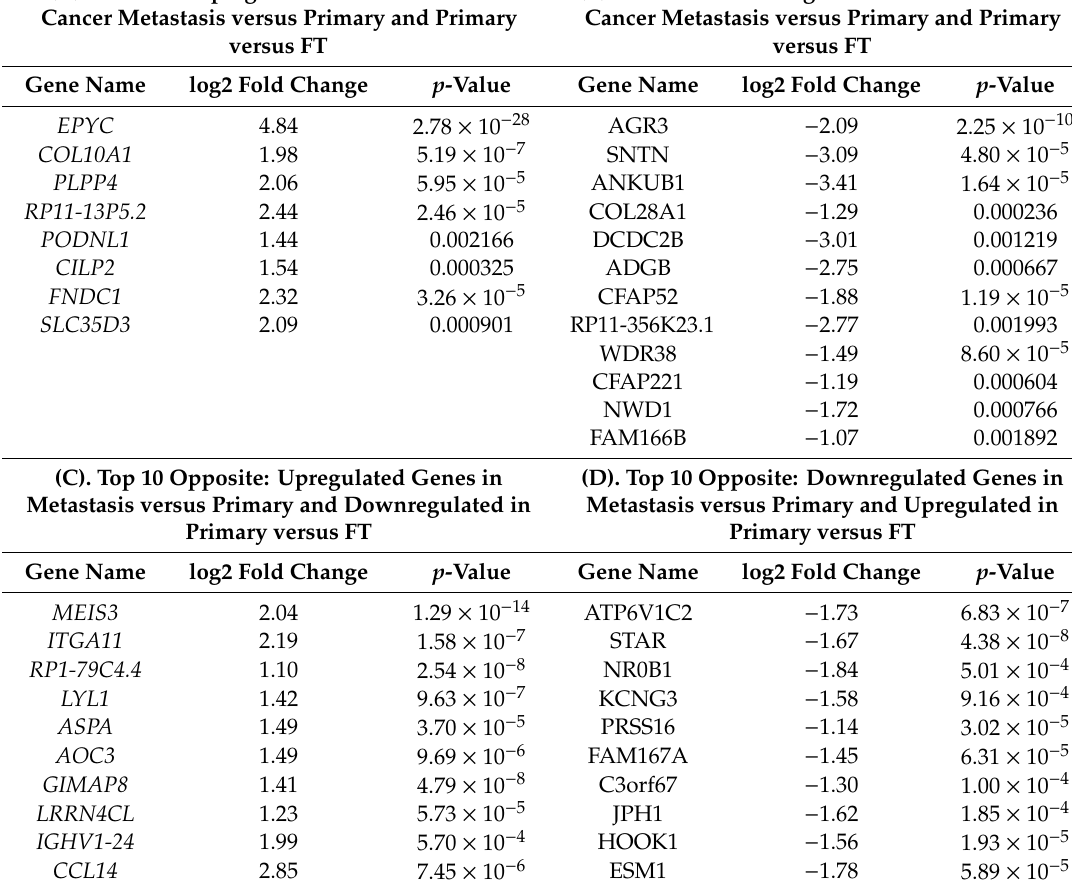
Table 2. Common genes in metastasis versus primary tumors and primary tumors versus FT. (A). Common Upregulated Genes in Ovarian (B). Common Downregulated Genes in Ovarian Cancer Metastasis versus Primary and Primary Cancer Metastasis versus Primary and Primary versus FT